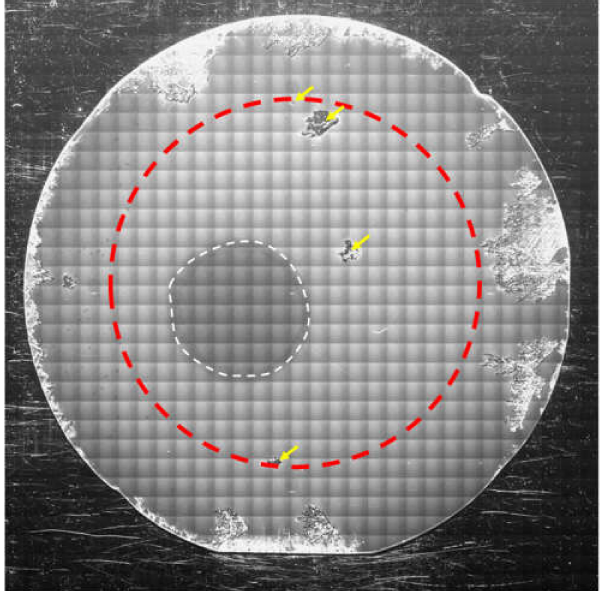
Figure 8. PL image of the on-axis 4H-SiC homoepitaxial layer grown on the 3-inch substrate at the growth rate and ramp-up time of 40 µ m / h and 60 min,